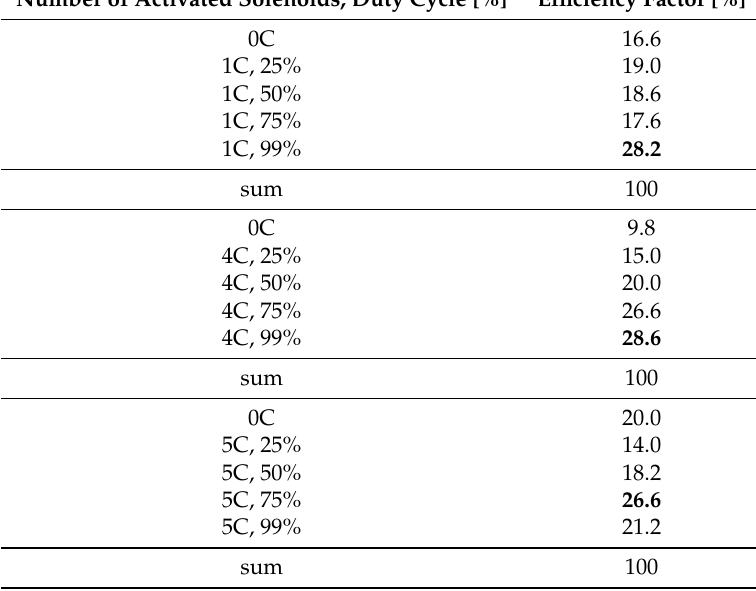
Table 7. Efficiency factors calculated for MFC5, depending on the number of solenoids and the value of duty cycle of a PWM signal.